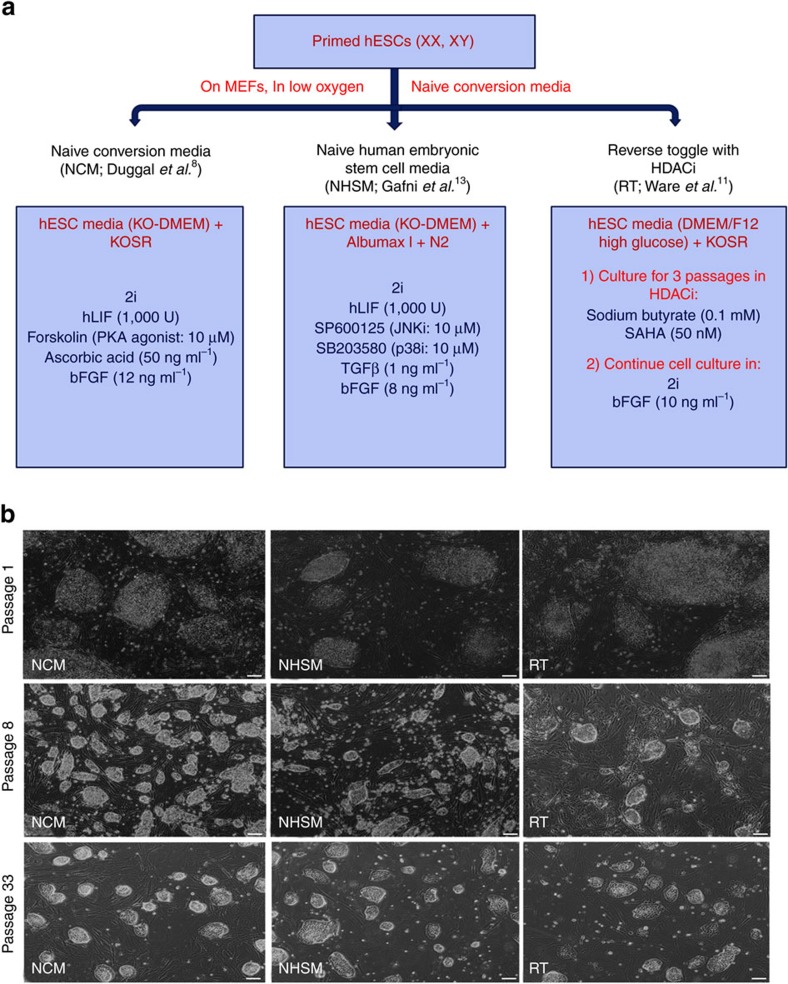
Conversion of primed hESCs towards a naive state in different naive media combinations.(a) Overview of small molecules and growth factors supplemented in NCM, NHSM and RT naive media. (b) Morphological analysis of hESC cultures in different naive media and their transition from primed pluripotency-specific flat morphology towards dome-shaped undifferentiated naive colonies. NCM and NHSM media comprised of several domed colonies whereas their frequency was lower in RT media. Scale bars, 200 μm.